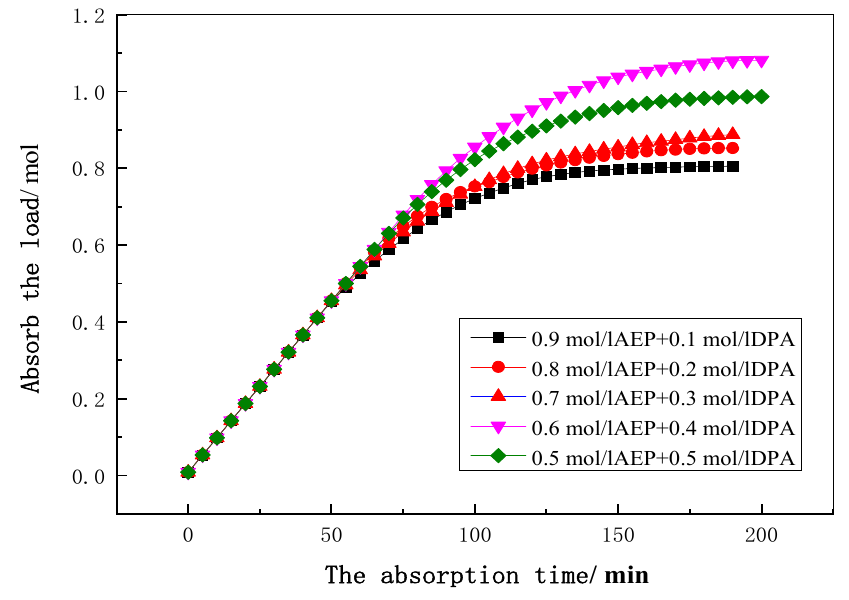
Figure 5. Absorption capacity and absorption time curve of AEP-DPA composite system. As can be seen from Table 5, for the AEP-DPA composite system, the regeneration temperature was the lowest at 98 ◦ C for the 6:4 and 7:3 ratios, followed by 98.5 ◦ C for the 5:5 and 8:2 ratios. As shown in Figure 6, under the same regeneration conditions, the regeneration amounts of the five composite absorption systems were as follows: 0.6 mol/lAEP − 0.4 mol/lDPA > 0.5 mol/lA- EP − 0.5 mol/lDPA > 0.9 mol/lAEP − 0.1 mol/lDPA > 0.7 mol/lAEP − 0.3 mol/lDPA > 0.8